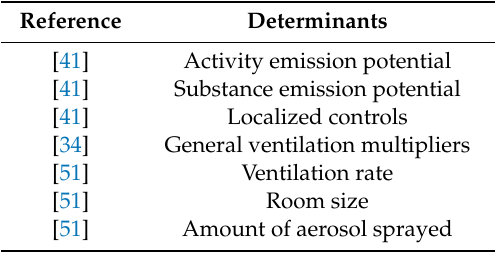
Table 5. Summary of the single determinants considered in di ff erent